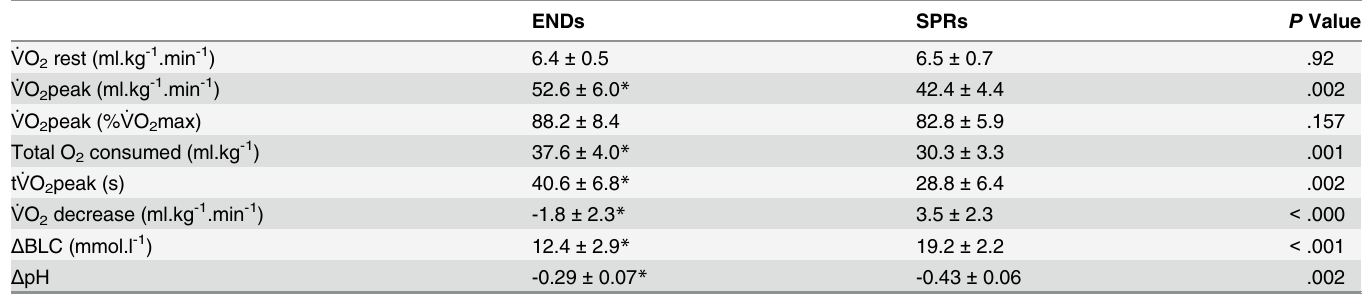
V ̇ O V ̇ O V ̇ O 2 peak is the time to achieve 2 peak; 2 decrease is the difference between the